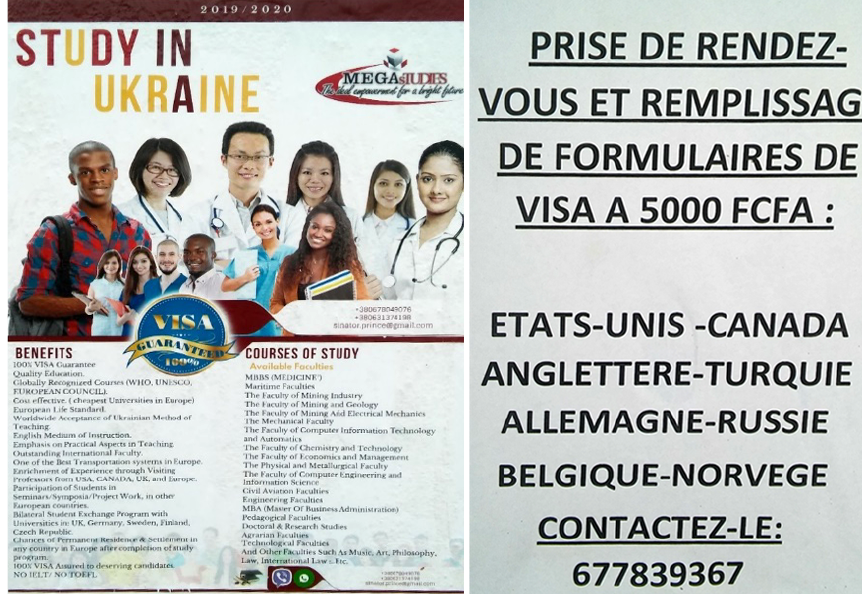
Figure 1. From left to right: Pole advertisement by broker of courses to study in Ukraine and advertisement at a cybercafé for those in need of a dokiman ’s assistance to fill out visa forms. Photos by the